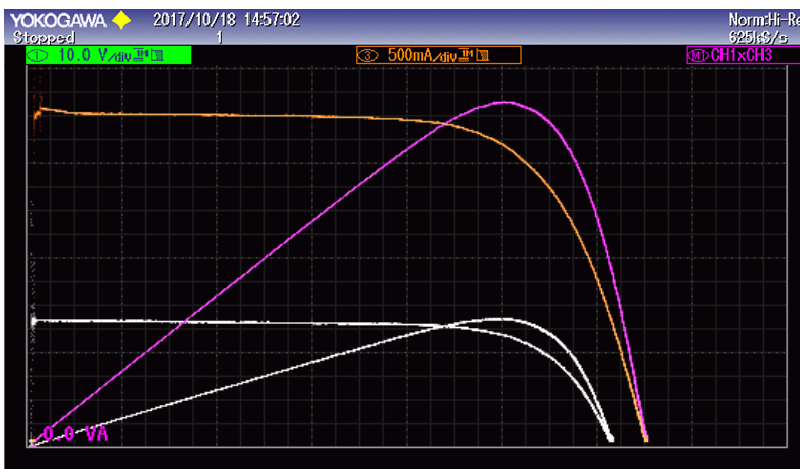
Figure 17. P - V and I - V characteristics of the PV array including the cable (Table 2) with an irradiance of 500 W/m 2 ( top ) and 200 W/m 2 (white sheet, bottom ) and T cell ≅ 35 °C (reference is made to Figure 16).